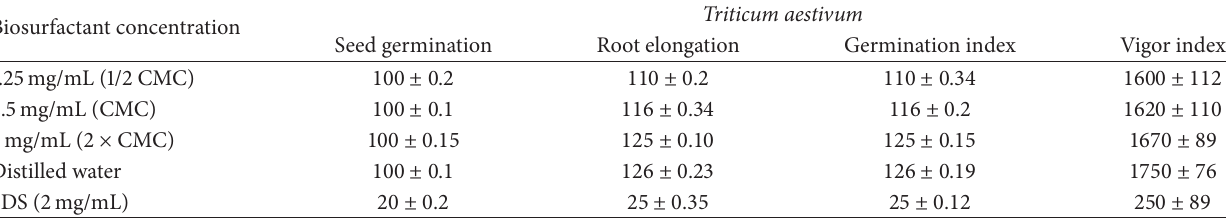
Table 2: Phytotoxicity evaluation of biosurfactant at different concentrations on Triticum aestivum . Biosurfactant